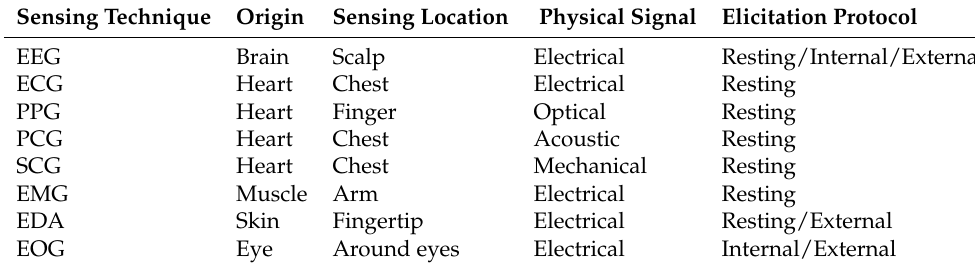
Table 1. Biosignals for cognitive